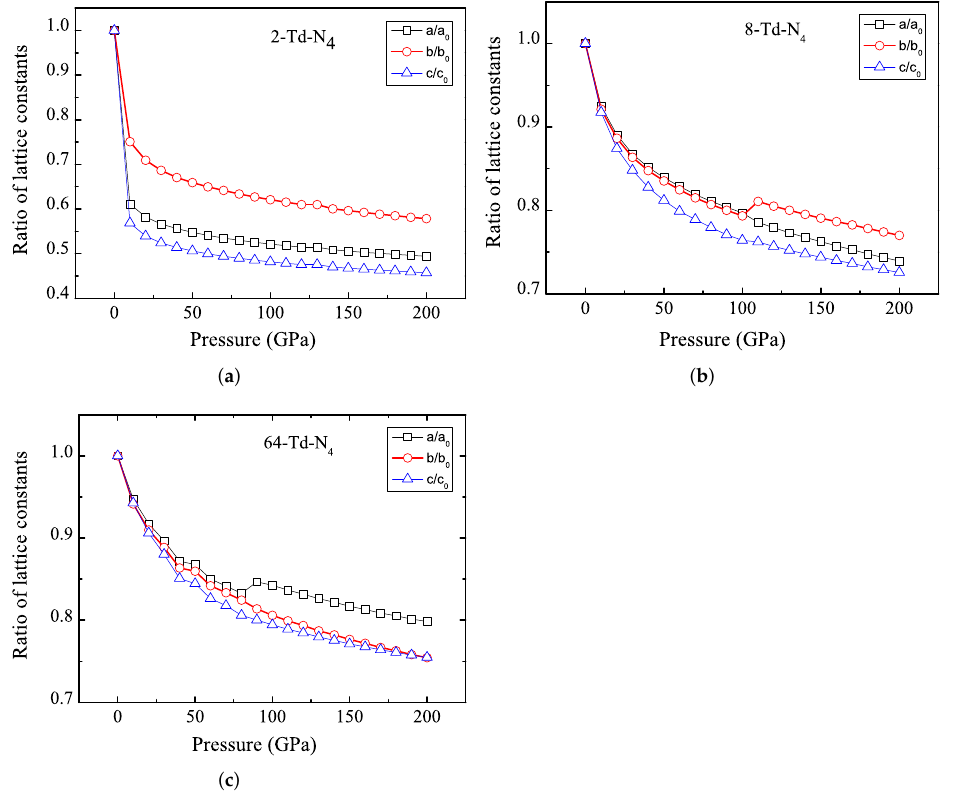
Figure 6. Ratio of lattice constants as a function of pressure for ( a ) 2-Td-N 4 , ( b ) 8-Td-N 4 , ( c ) 64-Td-N 4 . The PDF, ADF, and DDF of 64-Td-N 4 under different pressure levels were analyzed, as shown in Figure 7. The main peak represents the bond length and bond angle of the N 4 molecule. The main peak was consistent under different pressure levels, which indicates that Td-N 4 molecular crystals are only under compressive strain under high pressure, and the essential characteristics of molecular crystal remain unchanged. Figure 7a 1 shows that the system exhibited rich structures at r = 2 ∼ 5 ˚A under high pressure, which indicates that the pressure compressed the system and reduced the distance between atoms. However, when pressure was 380 GPa, the structure of the system broke, which can be clearly seen from DDF. The illustration in Figure 7a 3 is magnified DDF at 380 GPa. Due to the structural fracture of the system, peak values were scattered, and DDF values were small compared with those at other pressure